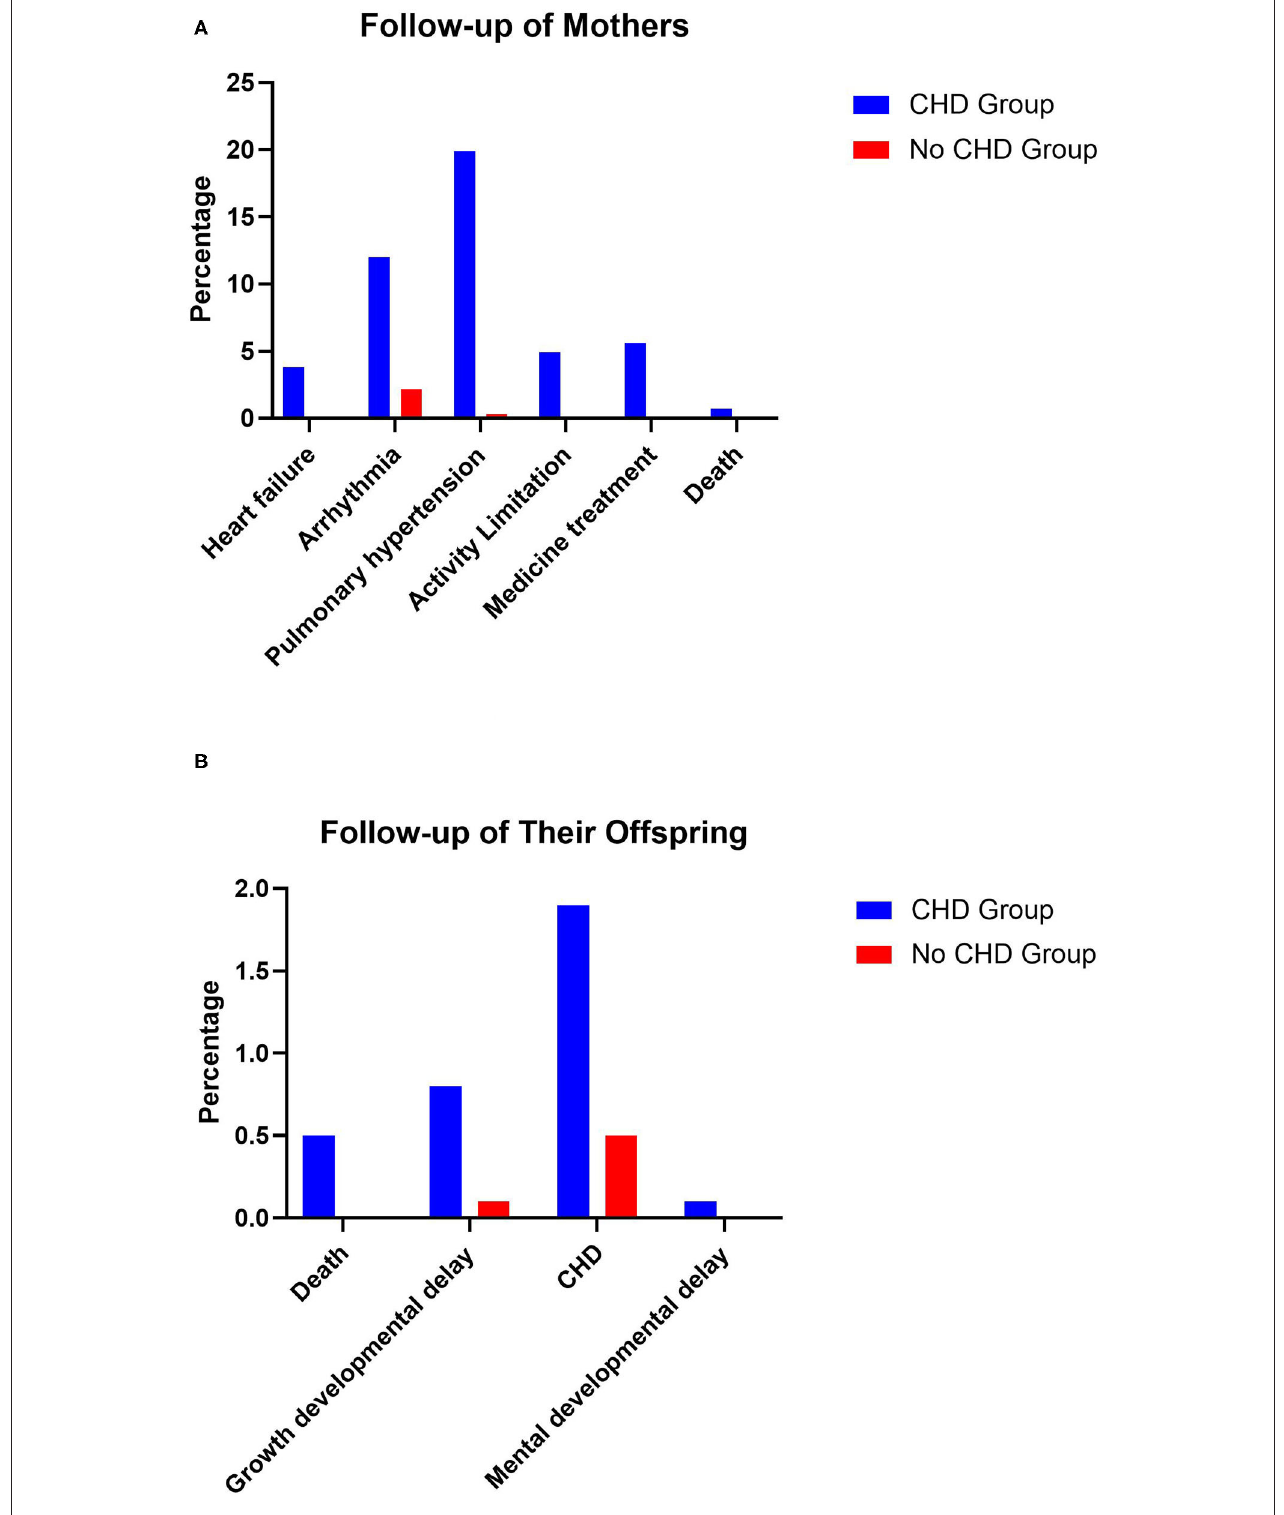
FIGURE 4 | Follow-up of the mothers and their offspring.